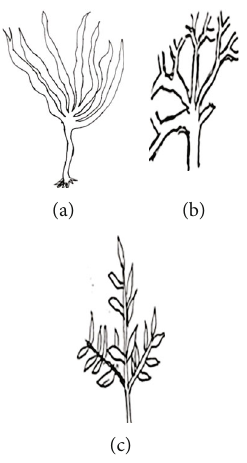
Figure 1: Characteristics of some brown algae (a) Laminaria , (b) Dictyota , and (c) Sargassum